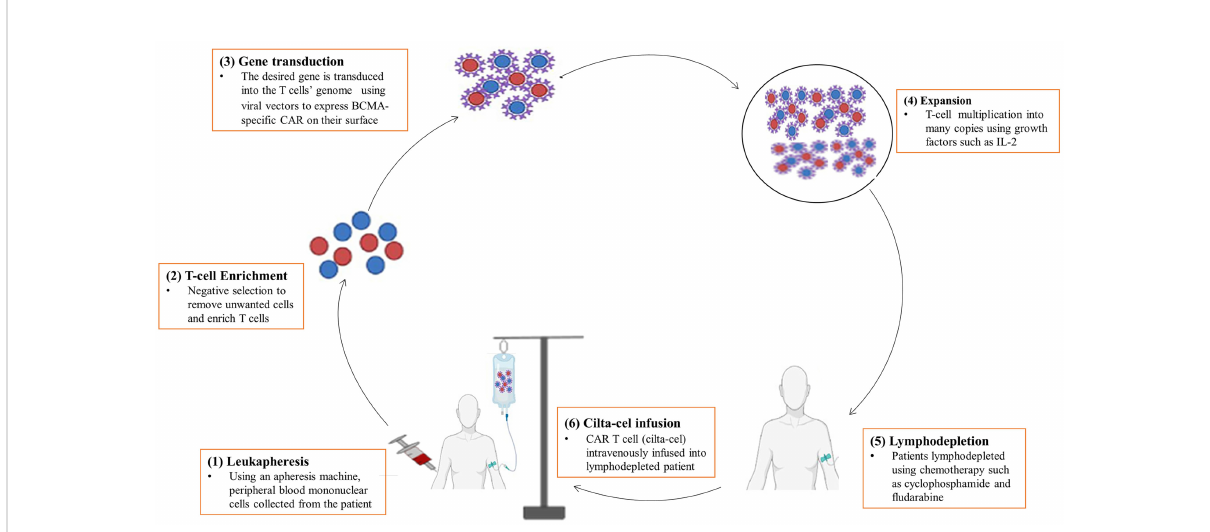
FIGURE 2 A diagrammatic representation of the manufacturing process of cilta-cel. It is prepared in the laboratory using several procedures, including (1) Leukapheresis, (2) T-cell enrichment, (3) Gene transduction, (4) Expansion, (5) Lymphodepletion, and (6) Cilta-cel